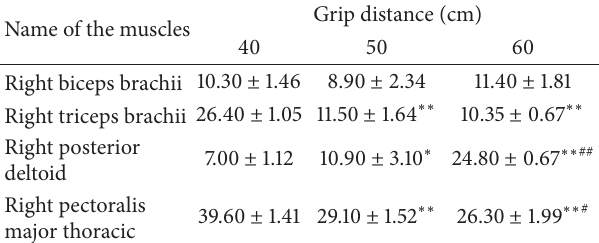
Table 5: Four muscles’ MVC% (%).